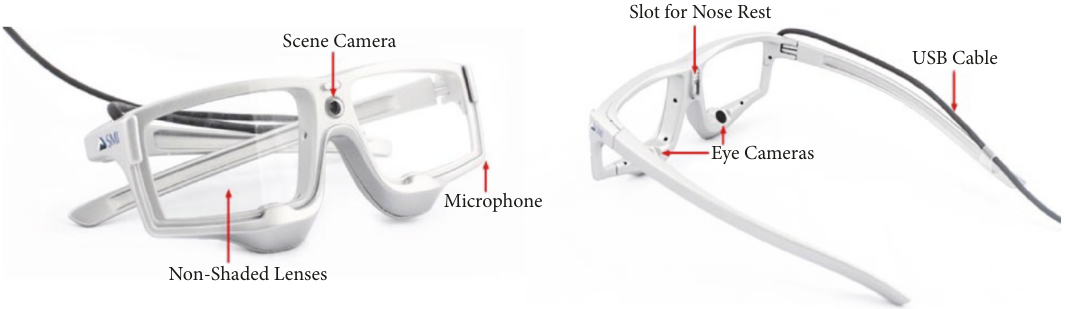
Figure 10: Eye tracking device.